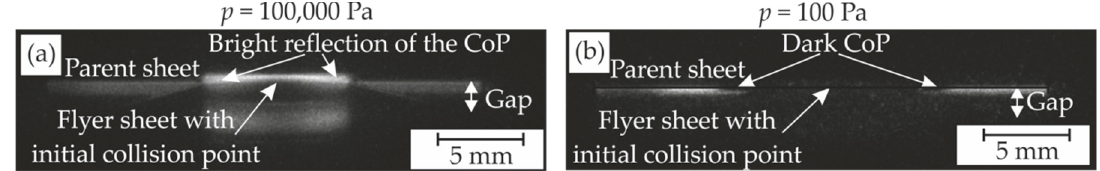
Figure 10. High-speed images of the MPW process at ( a ) normal ambient pressure and ( b ) at reduced Figure 10. High ‐ speed images of the MPW process at ( a ) normal ambient pressure and ( b ) at ambient pressure with v imp ≈ 243 m / s shortly after the initial collision. Welding directions to the left reduced ambient pressure with v imp ≈ 243 m/s shortly after the initial collision. Welding directions to and right from the central initial collision the left and right from the central initial collision point.